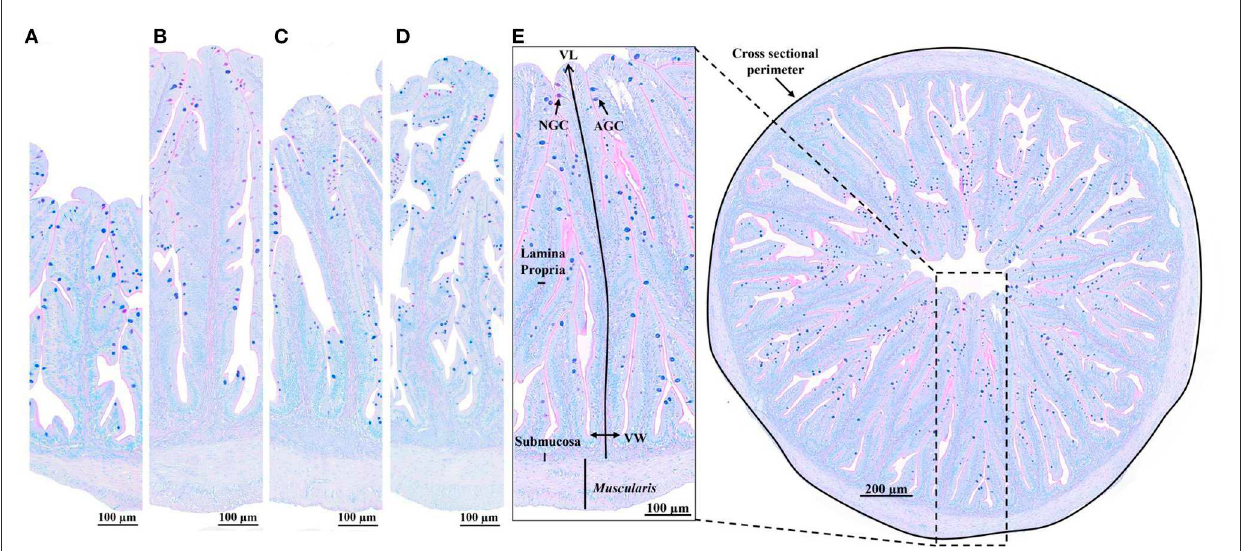
FIGURE1 Histological sections (Alcian blue/PAS staining, pH = 2.5) of the anterior intestine of European seabass fed (A) commercial-based diet without algae blend inclusion (control diet; Algae0), (B) control diet with 2% algae blend inclusion (Algae2), (C) control diet with 4% algae blend inclusion (Algae4), and (D) control diet with 6% algae blend inclusion (Algae6). (E) Measured parameters: cross-sectional perimeter, villus length (VL), villus width (VW), muscularis, submucosa and lamina propria width, acid goblet cells (AGC, blue), and neutral goblet cells (NGC, pink).